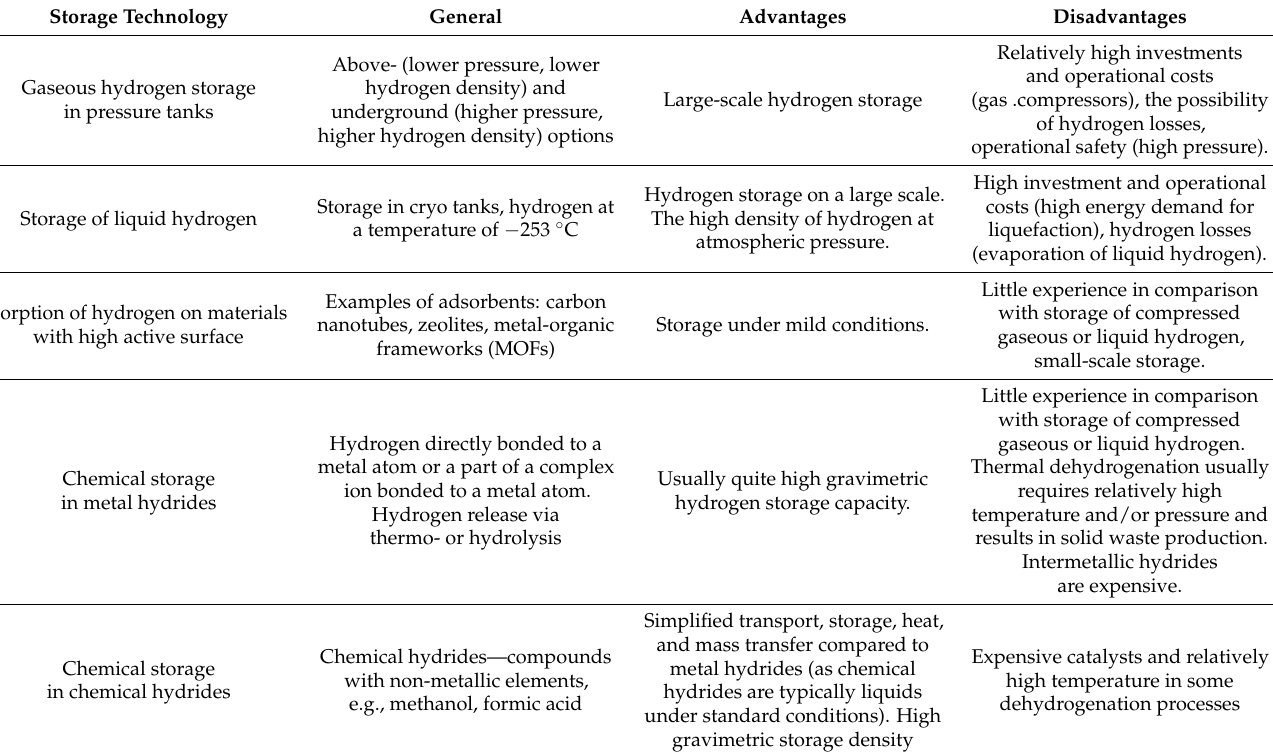
Table 1. General comparison of available hydrogen storage